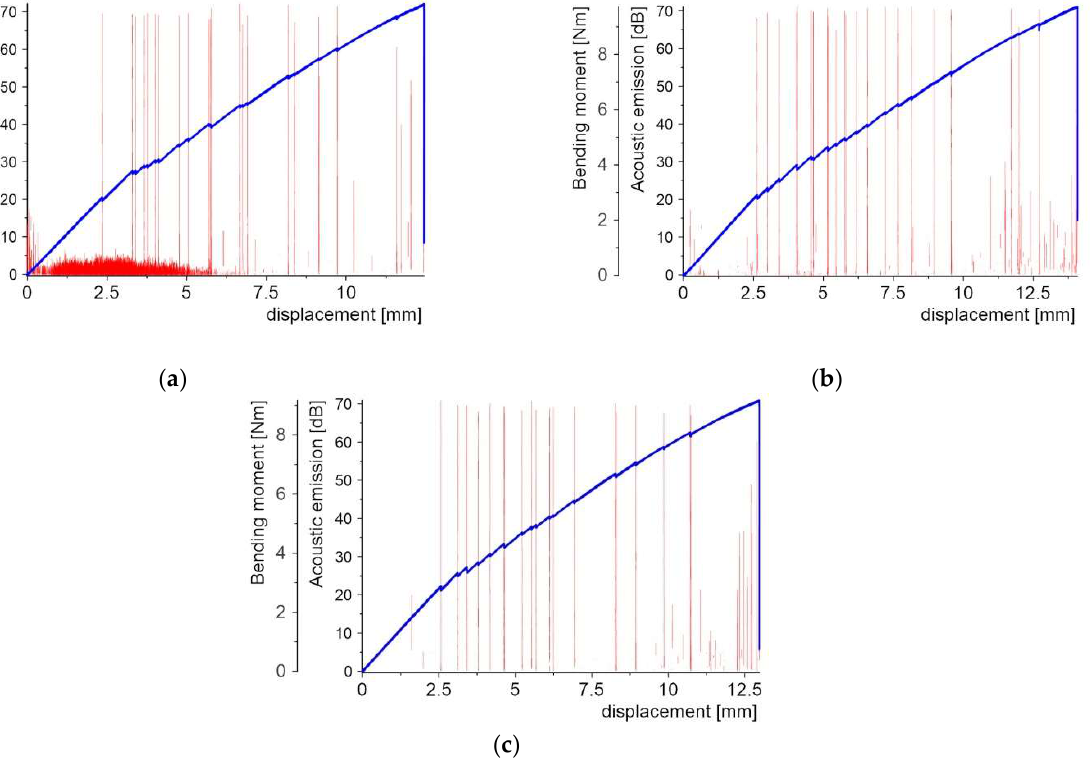
Figure 10. the AE signal distribution was found to be completely different from the previous cases. Figure 10. Bending moment and AE vs. displacement plots for samples with Al2O3 PL: ( a ) sample 3_1; ( b ) sample 3_2; and ( c ) sample